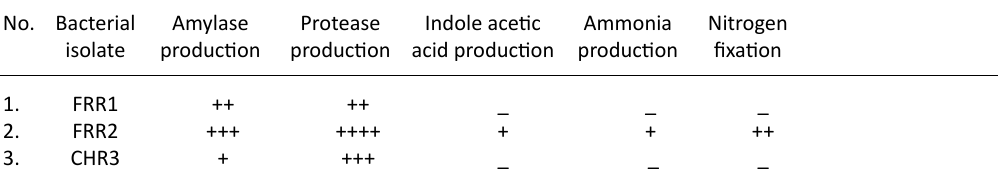
table 2. Endophytic bacterial secretions for plant growth promotion No. Bacterial